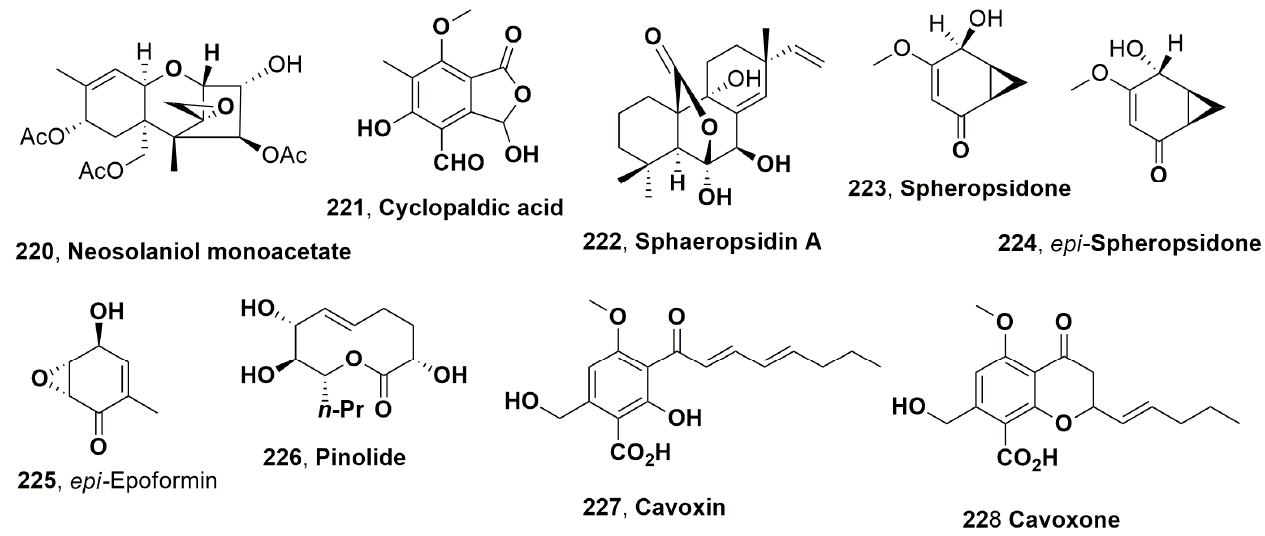
Figure 10. Metabolites produced by Fusarium co mpactum ( 220 ), Seiridium cupressi ( 221 ) Diplodia cu- pressi ( 222 – 225 ), Dydimella pinodes ( 226 ), Phoma cava ( 227 and 228 ). cupressi ( 222 – 225 ), Dydimella pinodes ( 226 ), Phoma cava ( 227 and 228